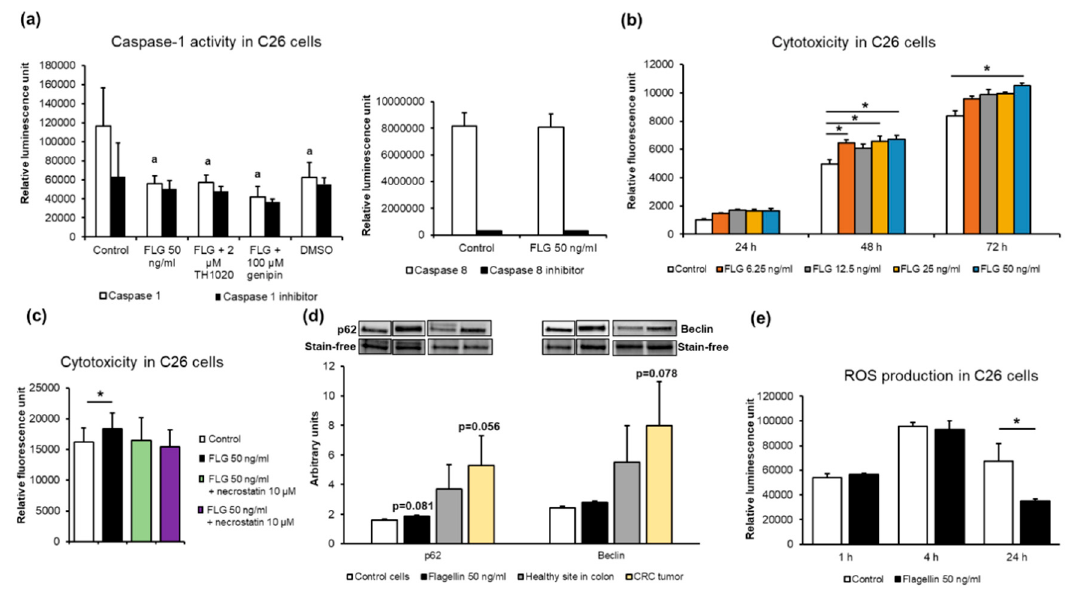
Figure 7. Flagellin (FLG) exposure ( a ) decreased C26 cancer cell apoptosis, i.e., caspase-1 activity ( n = 4 per treatment), but not caspase-8 activity. ( b ) Flagellin increased cytotoxicity ( n = 4 per treatment). ( c ) Flagellin-induced cytotoxicity was not affected by the Receptor-interacting protein (RIP) kinase inhibitor necrostatin in C26 cells. ( d ) The expression of the autophagy marker p62 tended to be increased in flagellin-treated C26 cells and CRC tumors compared to controls. ( e ) Flagellin exposure for 24 h decreased ROS levels in C26 colon cancer cells ( n = 4 per treatment). a = statistically significant difference compared to control and * denotes a significant difference between the groups that are connected with lines. FLG = flagellin; TH1020 = TLR5 antagonist; ROS, reactive oxygen species.